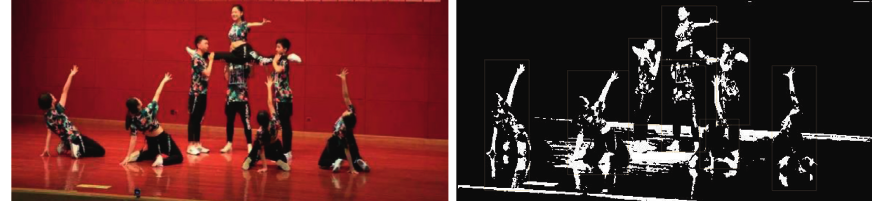
Figure 9: Recognition result of 3D visual image of aerobics action by deep neural network.